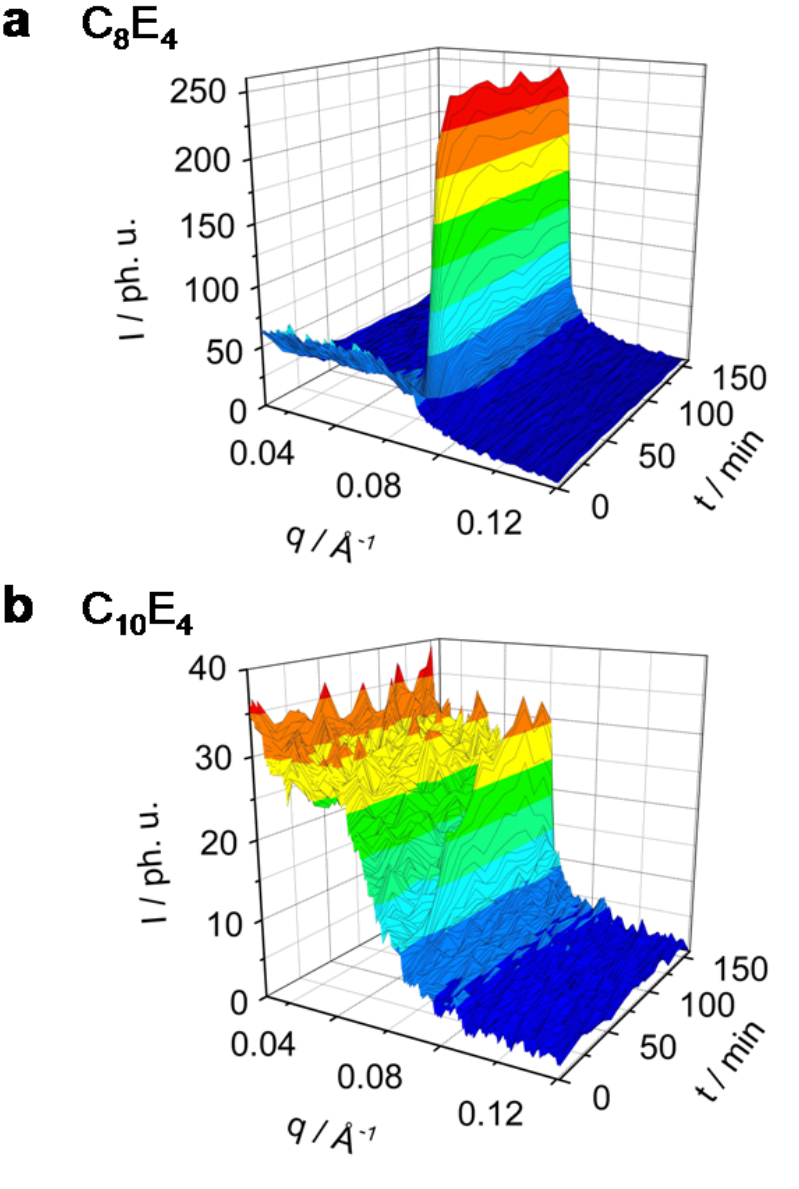
Figure 2. Rh101 dye-sensitized ME → LC phase transition in the system C C E ( b ) investigated by time-resolved photo small angle x-ray scattering (TR-SAXS). 10 4 C E transforms completely and reaches a new equilibrium within 50 min. A significant 8 4 decrease of the ME phase has been observed. C on long time